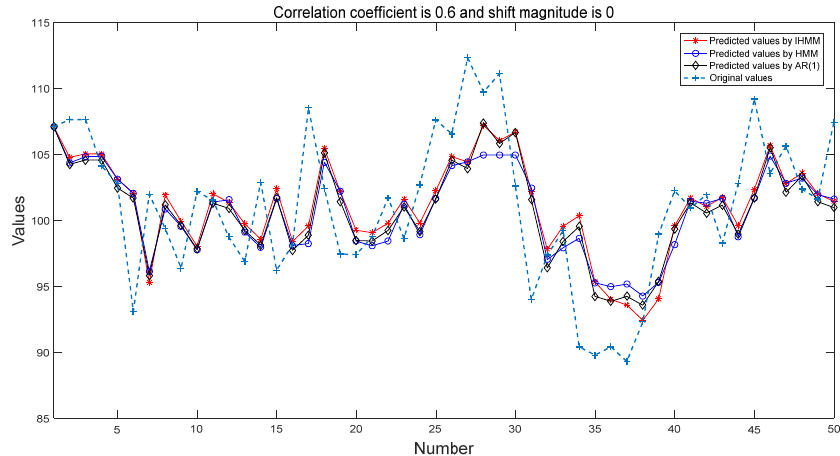
Figure 4. The predicted results of three models under an in-control process.